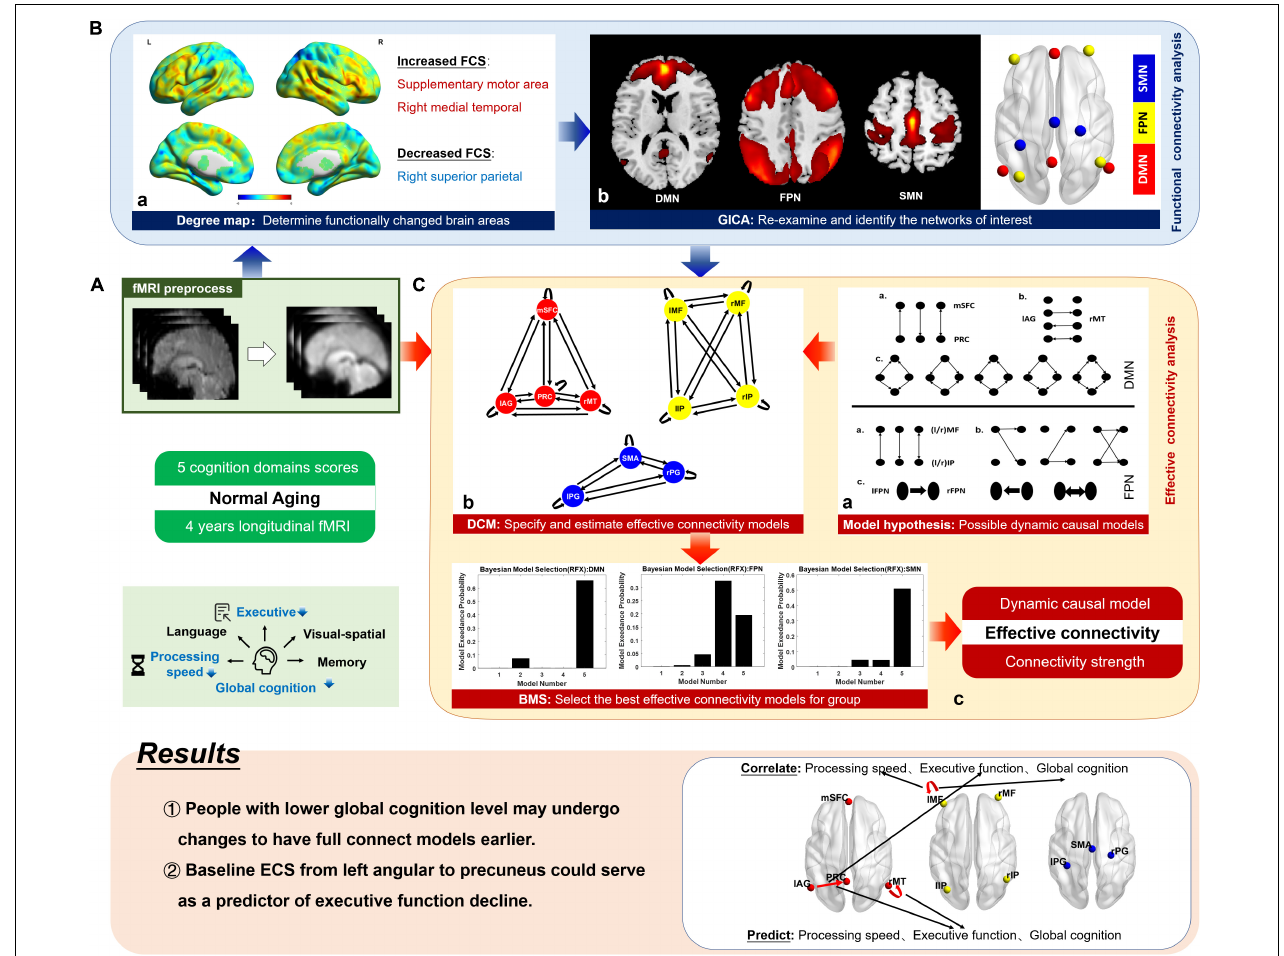
FIGURE 1 | Schematic of the method. Based on the 4-year longitudinal fMRI data and five cognitive domain scores of 37 cognitively normal elderly people, we explored the alterations in the dynamic causal model structure (information propagation pathways) and effective connectivity strength (causal interaction strength) during the aging process. Supplemented by functional connectivity analysis (B) , this study mainly focused on effective connectivity analysis (C) , and its relationship with cognitive decline was further investigated (shown in results). (A) The raw fMRI data were preprocessed, including slice-timing correction, realignment, normalization, smoothing, and bandpass filtering. (B) a. We generated a degree map, which represents the voxel-based functional connectivity for each participant and compared the group-level differences between the two time points. According to family-wise error-corrected results, areas whose functional connectivity strength (FCS) significantly changed were listed. The figure shows uncorrected results, from which we can see the patterns of FCS alteration in the whole brain. b. We identified the brain networks to which significantly changed areas belong using temporal concatenation group independent component analysis (GICA). The three networks of interest were the default mode network (DMN), the fronto-parietal network (FPN), and the somatomotor network (SMN). A paired t-test was employed on the spatial maps of three networks and functional connectivity changes inner networks were found again. The spatial maps were then thresholded into clusters, and the networks were simplified into regions centering on the peak locations in the GICA maps at the group level. (C) a. We formulated a hypothesis for possible causal interaction model structures for the DMN and FPN. For the SMN, all mathematically possible models were considered. This provided a reasonable model space for dynamic causal modeling. b. Based on the preprocessed fMRI data, using coordinates from functional connectivity analysis, we applied the dynamic causal modeling method over predefined model space to specify and estimate the effective connectivity models. c. We then used the Bayesian model selection method to select the optimal model structure for the group by investigating how interactions at the neuronal level may have generated the observed data. The figure shows the simplified model selection result, and the optimal model was obtained using model exceedance probability. mSFC, medial superior frontal cortex; PRC, precuneus; lAG, left angular gyrus; rMT, right middle temporal gyrus; l/rMF, left/right middle frontal gyrus; l/rIP, left/right inferior parietal gyrus; SMA, supplementary motor area; l/rPG, left/right postcentral gyrus.